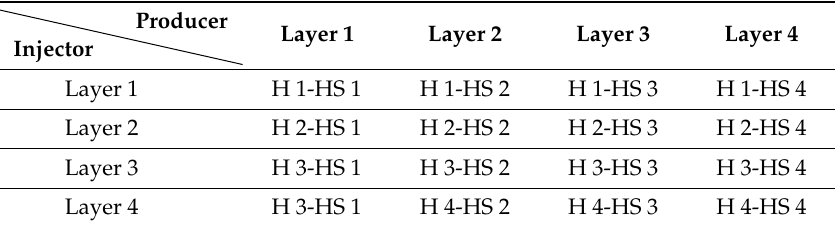
Table 5. Well pattern descriptions of the H-HS